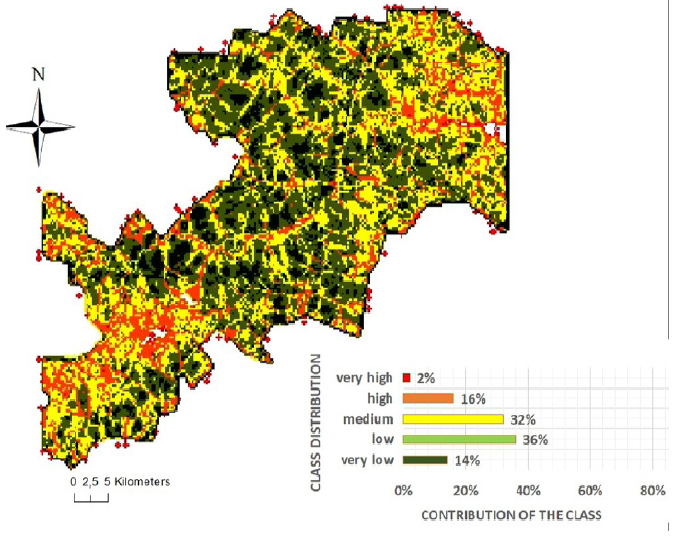
Figure 2. Komati Gorge hydrography factor